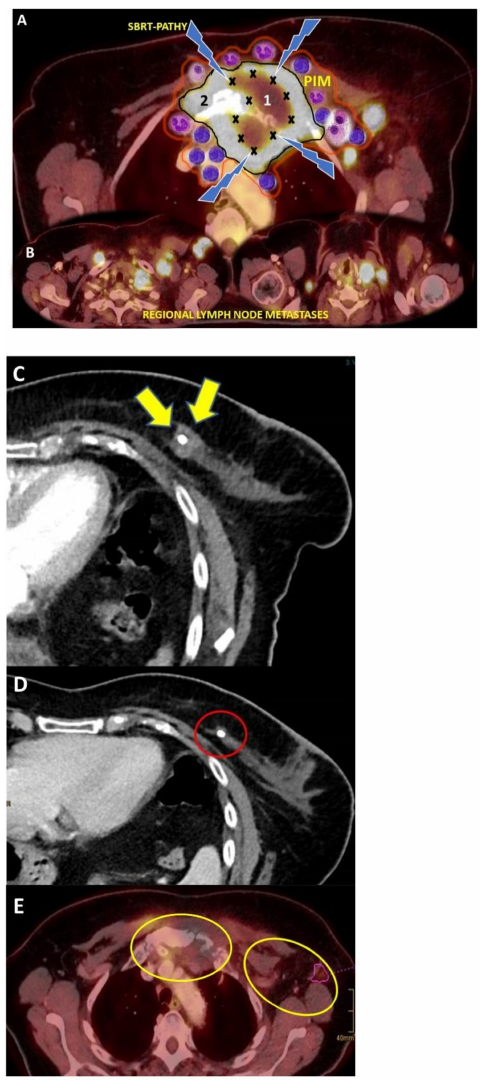
Figure 1. Principle and outcomes of SBRT-PATHY: ( A ) Planning FDG-PET-contrast-enhanced CT shows a large bone metastasis of primary breast cancer infiltrating the nearby soft tissues. Addition- ally, this 64-years old patient had multiple regional, bilateral lymph node metastases ( B ). After having experienced the disease progression following chemotherapy, this patient was enrolled in the phase I prospective study and submitted to SBRT-PATHY 10 Gy × 3 prescribed to the 70%-isodose line, delivered to the hypovascularized and hypometabolic tumor segment (marked with “X”)-junctional zone between the central necrotic (1) and peripheral hypervascularized and hypermetabolic tumor segment (2) as shown in A. PIM (Peritumoral Immune Microenvironment-red contour) surrounding the tumor surface (black contour) has been maximally spared from radiation in order to preserve its functionality and potential role in mediating the bystander and abscopal effects ( A ). The control CT 2 months after SBRT-PATHY showed complete response of untreated primary breast cancer due to the abscopal effect. ( C ) primary breast cancer (indicated by the yellow arrows and marked by the surgical clip) before SBRT-PATHY; ( D ) complete disappearance of untreated primary breast cancer (indicated by the red ring) after SBRT-PATHY delivered to the bulky bone metastasis. ( E ) PET-CT 5 months following SBRT-PATHY showed complete response of partially irradiated bulky bone metastasis due to the bystander effect, but also of unirradiated regional lymph node metastases because of the abscopal effect (indicated by the yellow contours, in respect to